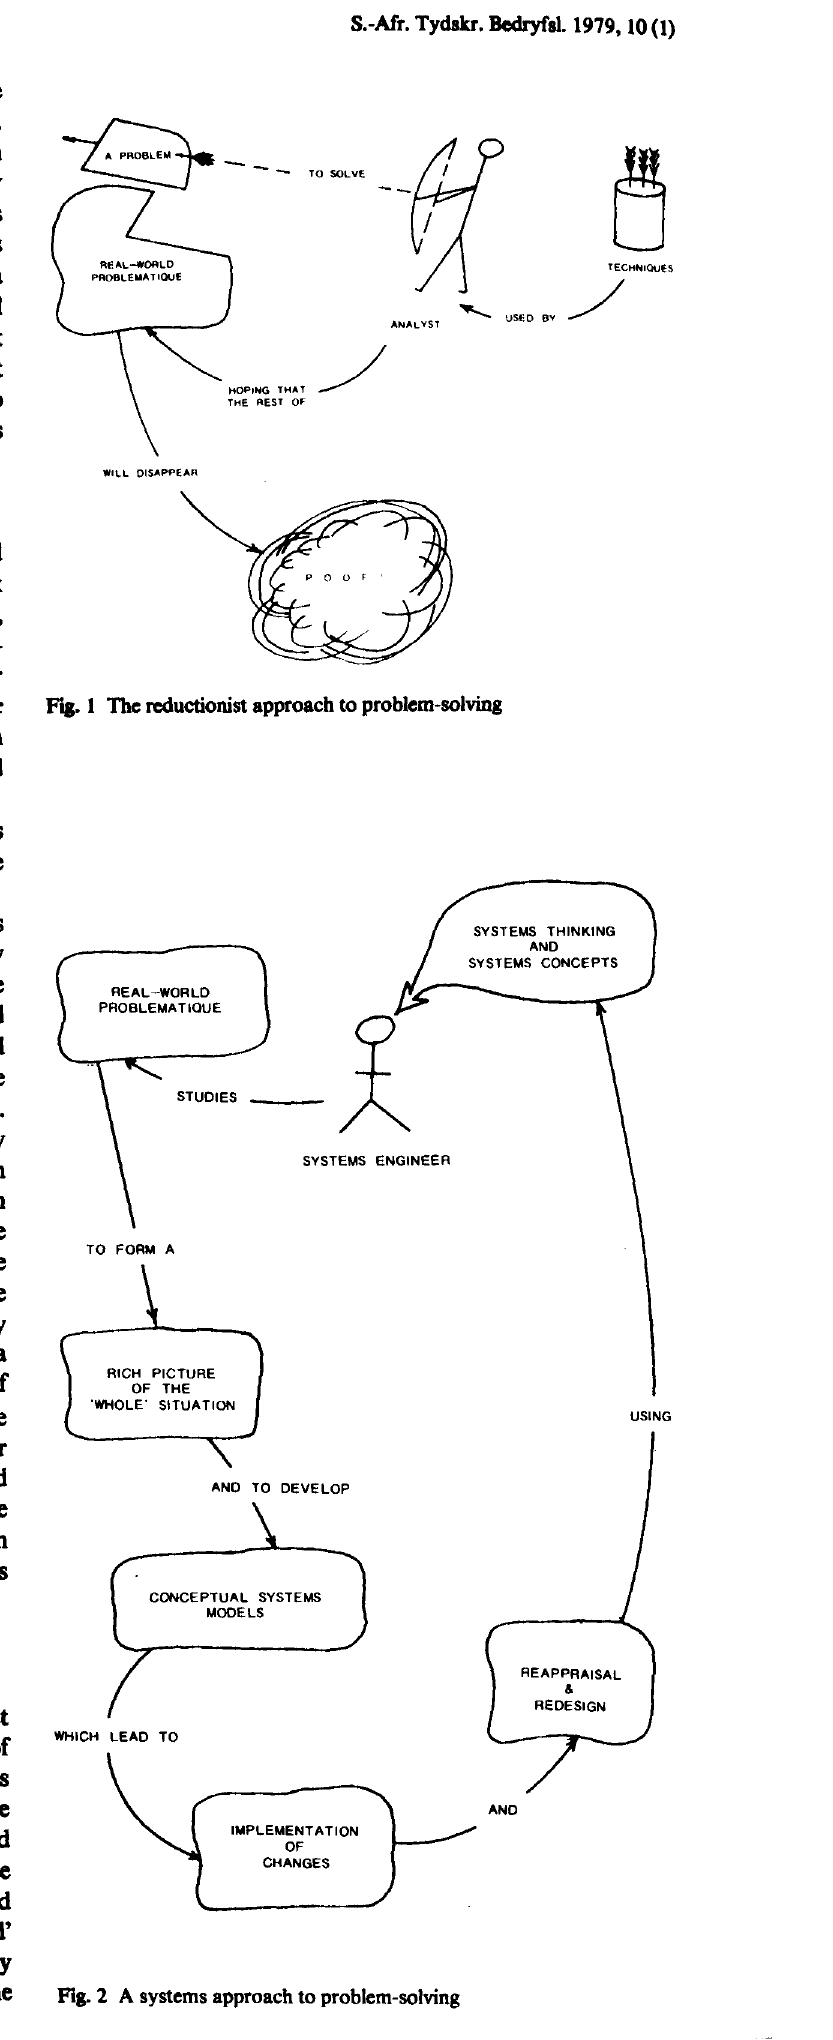
Fig. 2 A systems approach to